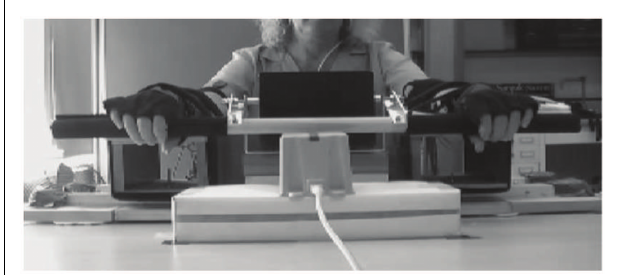
FIGURE 1 | Custom-made wrist extension trainer